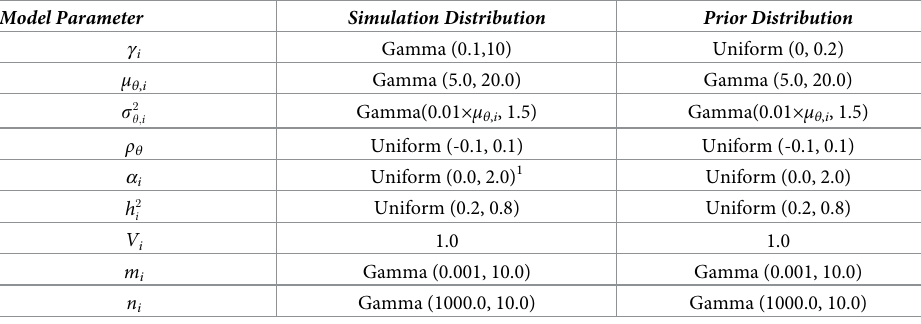
Table 2. Distributions for simulation parameters and prior distributions.